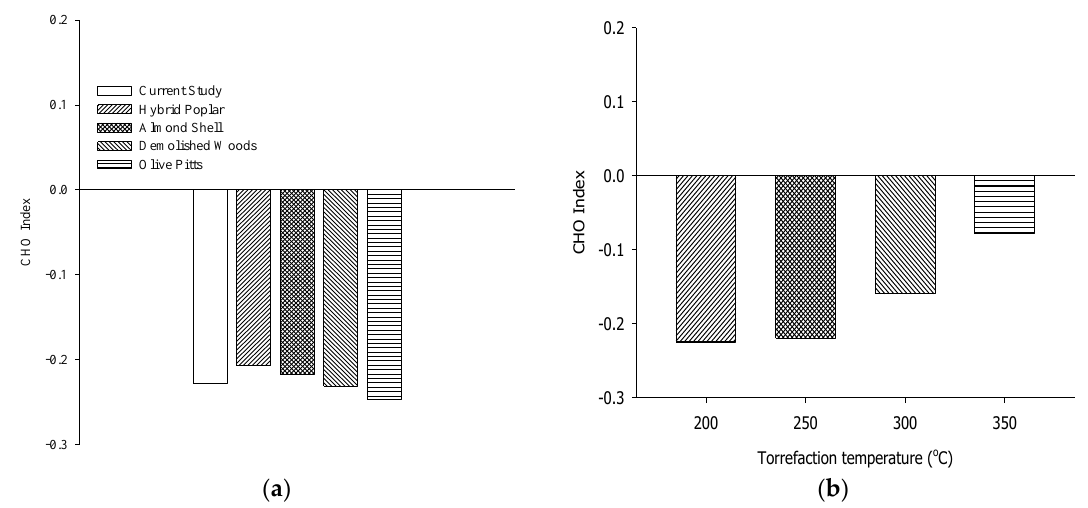
Figure 5. CHO index values of ( a ) biomass feedstocks (data adapted from Reference [21]) ( b ) waste wood with respect to torrefaction temperature.